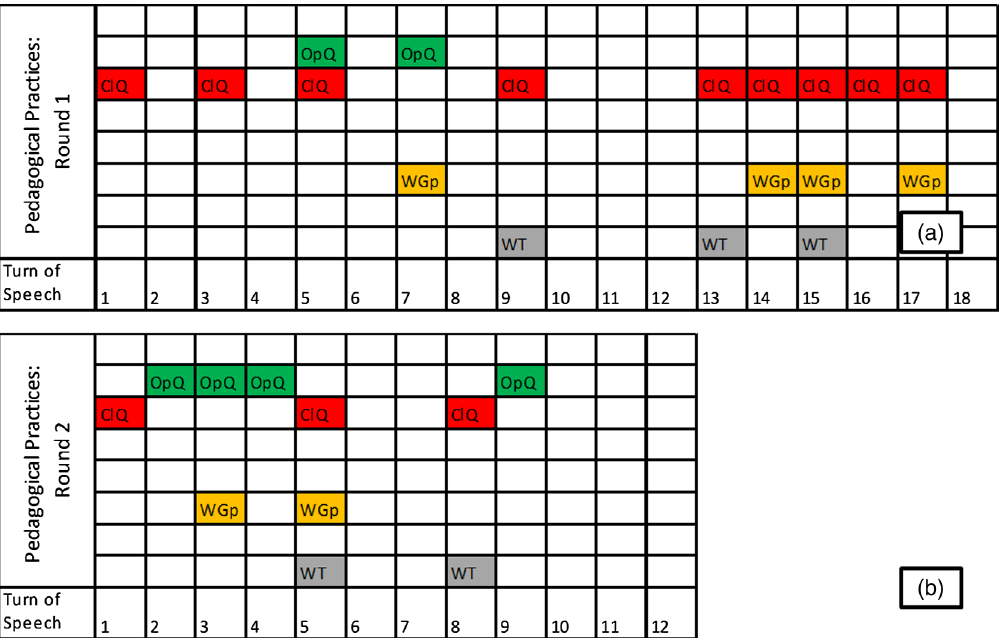
3. Pedagogical skill use by LA-3C. This LA increased his use of open questions in the second round of teaching the student- avatars. The transcripts for these interactions are available in the Supplemental Material. Codes are as follows: Eli ¼ Elicit Prior Knowledge; OpQ ¼ Open Question; ClQ ¼ Closed Question; LdQ ¼ Leading Question; RWE ¼ Real World Example; WGp ¼ Whole Group Involvement; Upt ¼ Uptake; WT ¼ Wait